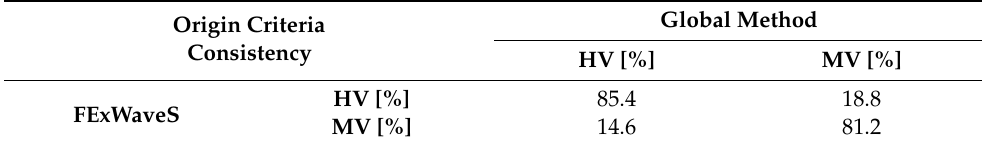
Table 4. Origin assessment: criteria consistency expressed in percentage with respect to the Global Method.